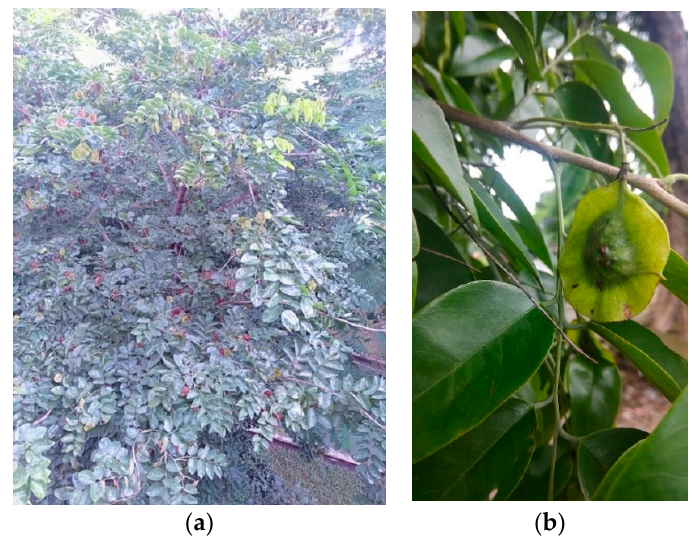
Figure 9. Pterocarpus marsupium : ( a ) whole plant and ( b ) leaves.